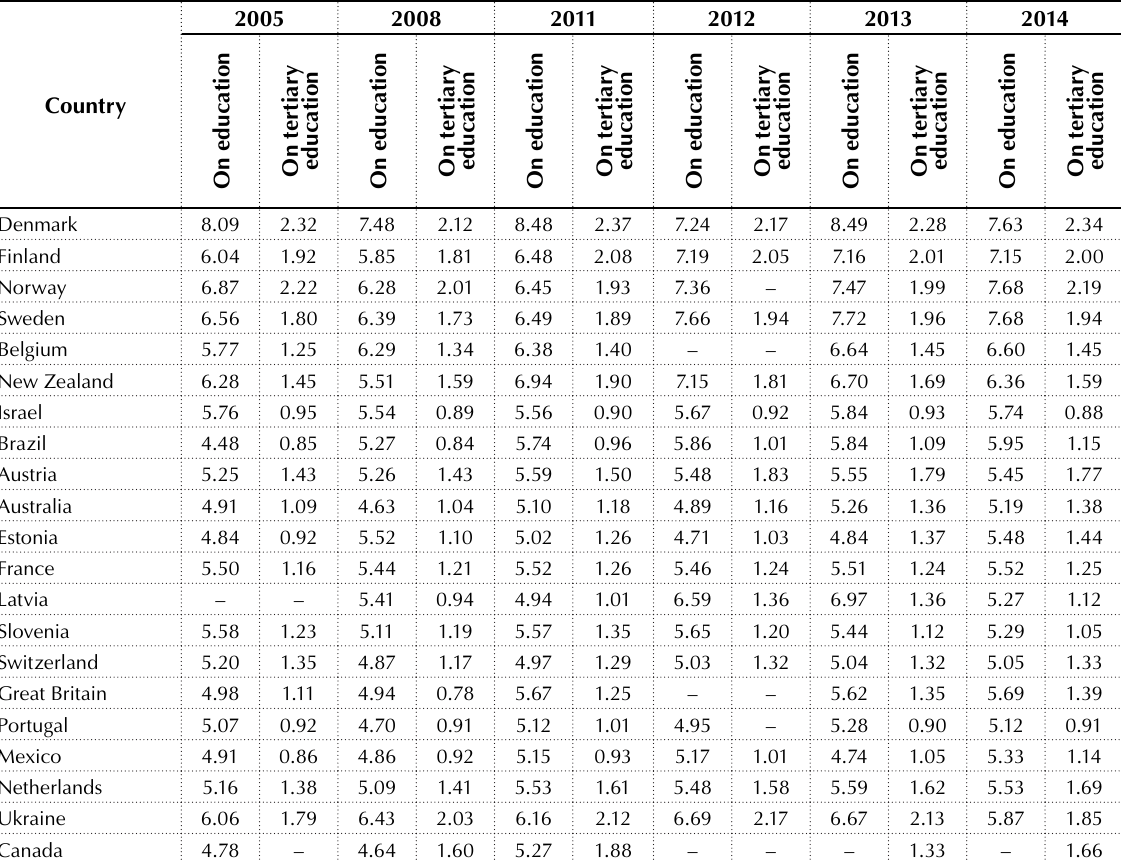
Table 3. Government expenditure on education and on tertiary education as a percentage of GDP (2005–2014),